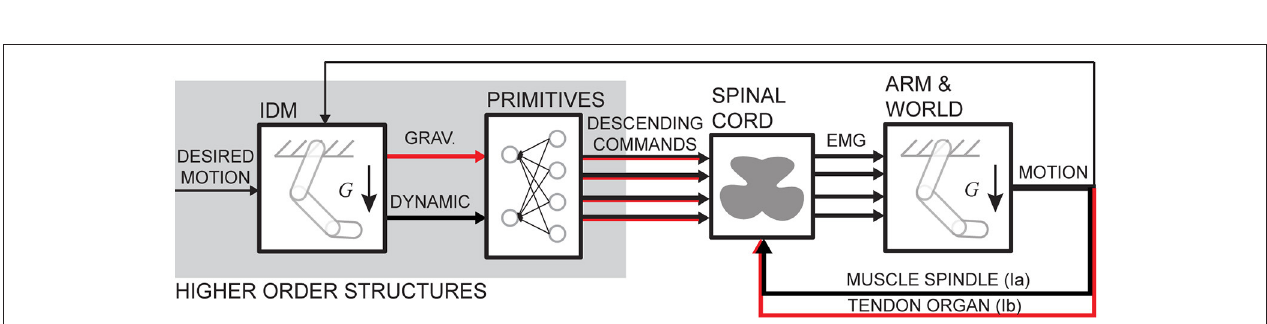
Frontiers in Human Neuroscience | www.frontiersin.org